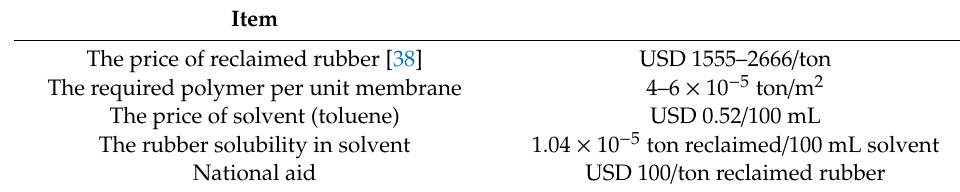
Table 3. Summary of material price data and assumptions in this